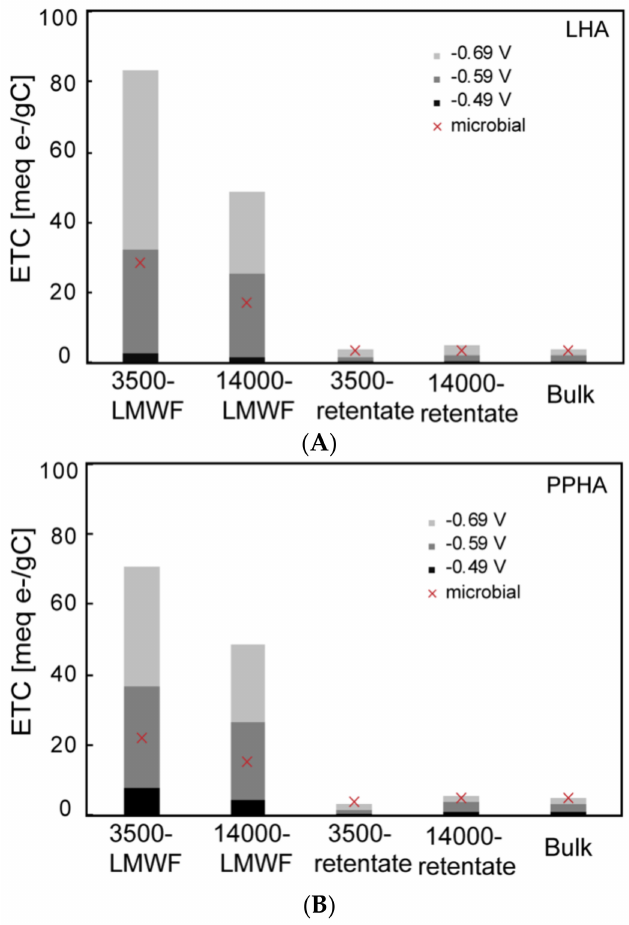
Figure 7. Comparison in per gram carbon ETC between electrochemical reduction and microbial reduction of HA with different molecular weight fractions. ( A ) LHA ( B )